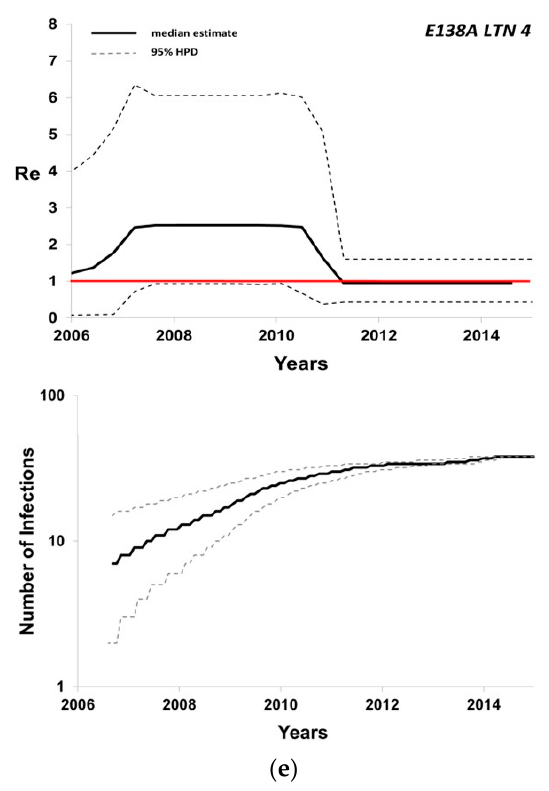
Figure 2. Bayesian skyline plots estimated by BEAST v2.1.3 using birth-death skyline serial models presenting the effective reproductive number ( R e ) over time, and the cumulative number of lineages (infections) in a logarithmic scale over time for the five subtype A1 local transmission networks (LTNs) with resistance: ( a ) K103N; ( b ) E138A LTN 1; ( c ) E138A LTN 2; ( d ) E138A LTN 3; ( e ) E138A LTN 4. Table 2. Characteristics of the study population infected with subtype A1 non-nucleoside reverse transcriptase inhibitors (NNRTI)-resistant viruses spread to local transmission networks (LTNs).